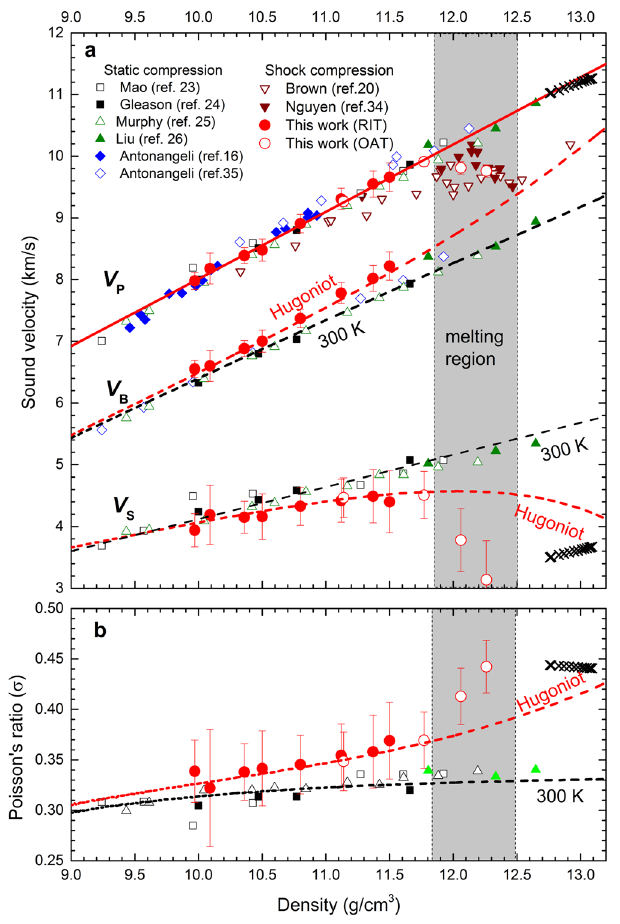
Fig. 1 Sound velocities and Poisson ’ s ratio of Fe as a function of density. a The measured V P along Hugoniot by the RIT (red solid circles) and the OAT (red open circles) are compared with previous shockwave data 20,34 . The solid red line represents the linear fi t to the V P measurements for solid Fe. The static V P data by NRIXS 23 – 26 and IXS 16,35 are also plotted for comparison. The measured V B along Hugoniot by the RIT and the derived V S from this study are shown by red circles, compared with NRIXS data with a natural 57 Fe isotope concentration at 300 K 23 – 26 . The black dashed line for V B is calculated from the equation of state at 300 K, and the red dashed V B -line is the calculated V B from Hugoniot equation of state. The black and red dashed lines for V S represent the calculated results from V P and V B , at 300 K and along Hugoniot, respectively. b The derived Poisson ’ s ratios σ from this study are compared with the room-temperature NRIXS data. All measurements are compared with the observed values (black crosses) from PREM 14 . The boundaries of the melting region (shaded area) were determined according to the discontinuities of the sound